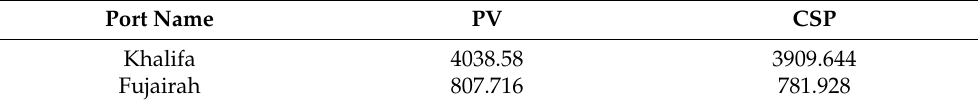
Figure 8. Comparison of hydrogen production in all technologies for 25 km energy scenario, in plants at port sites pathway. Table 8. Amount of H 2 produced at each port in the second pathway from PV and CSP in (kg × 10 6 ).